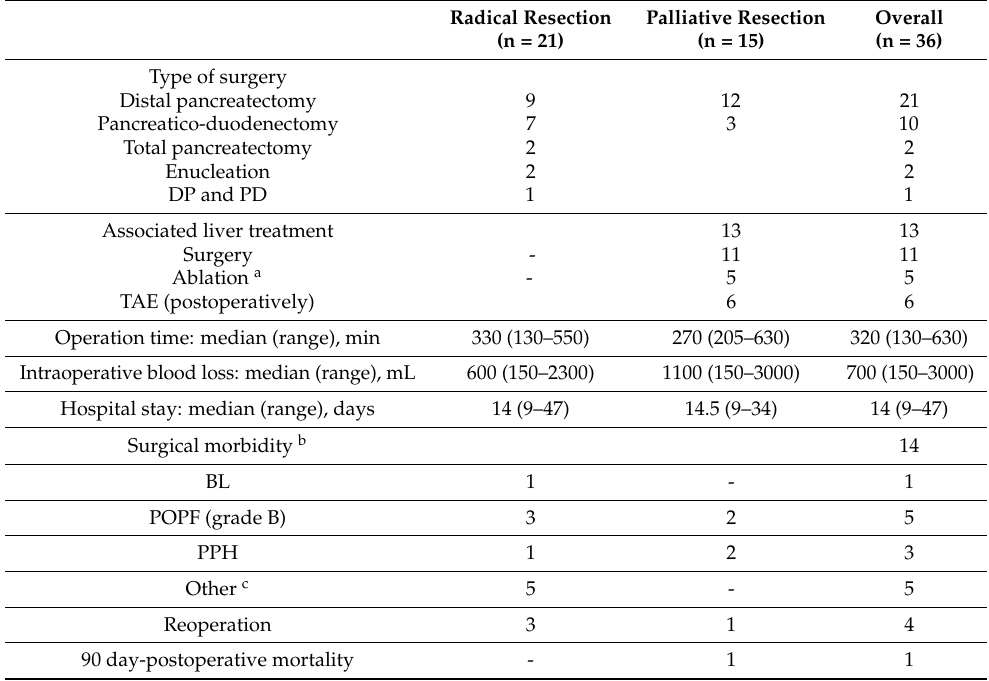
Table 2. Type of surgery and post-operative outcome of the operated patients (n = 36) with radical (n = 21) or palliative (n = 15)